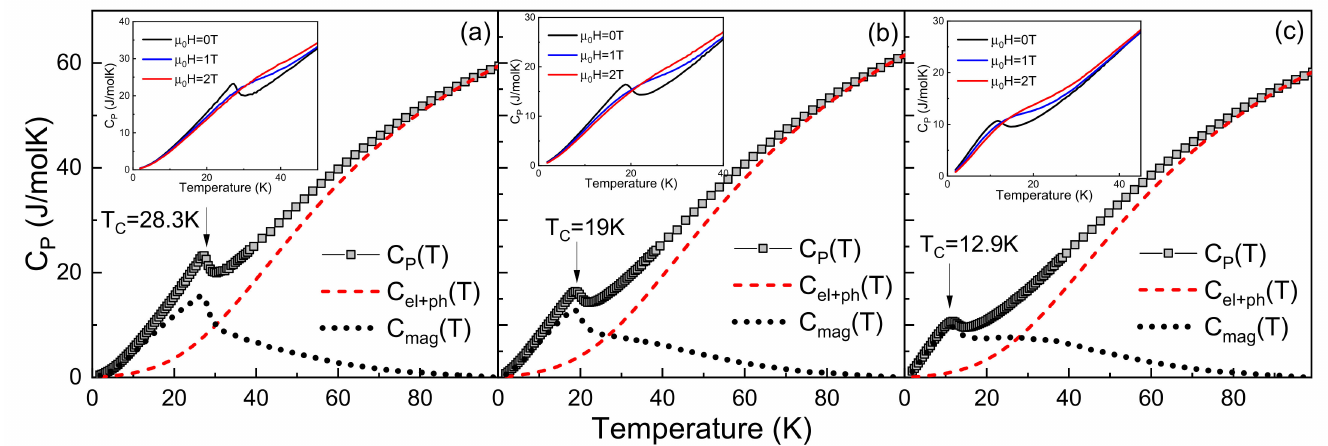
Figure 1. Total heat capacity C P ( T ) of Tb 0.75 Er 0.25 Ni 2 ( a ); Tb 0.5 Er 0.5 Ni 2 ( b ); and Tb 0.25 Er 0.75 Ni 2 ( c ); measured in a zero magnetic field. The calculated sum of electronic and phonon contributions C el+ph ( T ) as well as estimated magnetic contribution C mag ( T ) are shown. The insets in ( a – c ) show the heat capacity as a function of temperature measured in zero, 1- and 2 T magnetic fields,